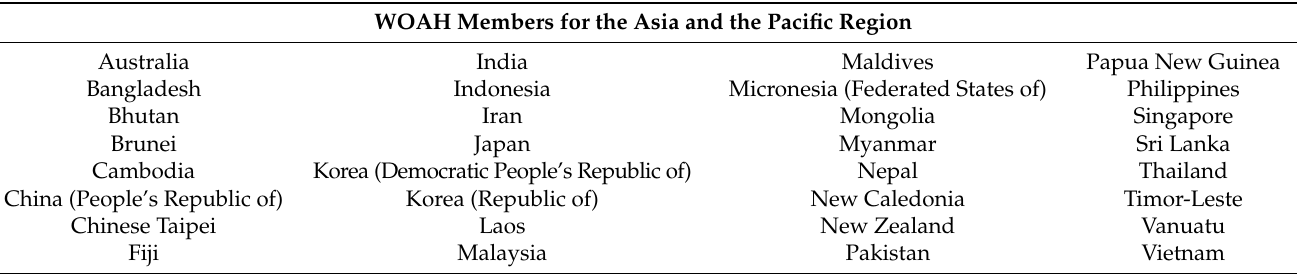
Table 1. World Organisation for Animal Health (WOAH) Members within the Asia and the Pacific Regions. WOAH Members for the Asia and the Pacific